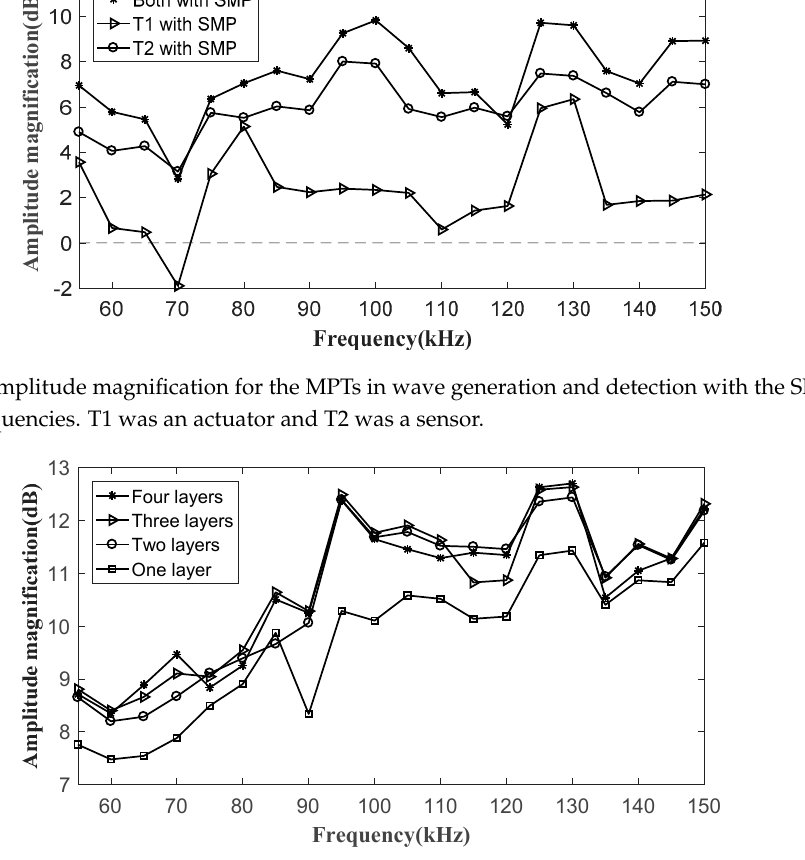
Figure 16. Amplitude magnifications for the MPT with multiple layers of SMPs at different frequencies. T1 was an actuator and sensor.